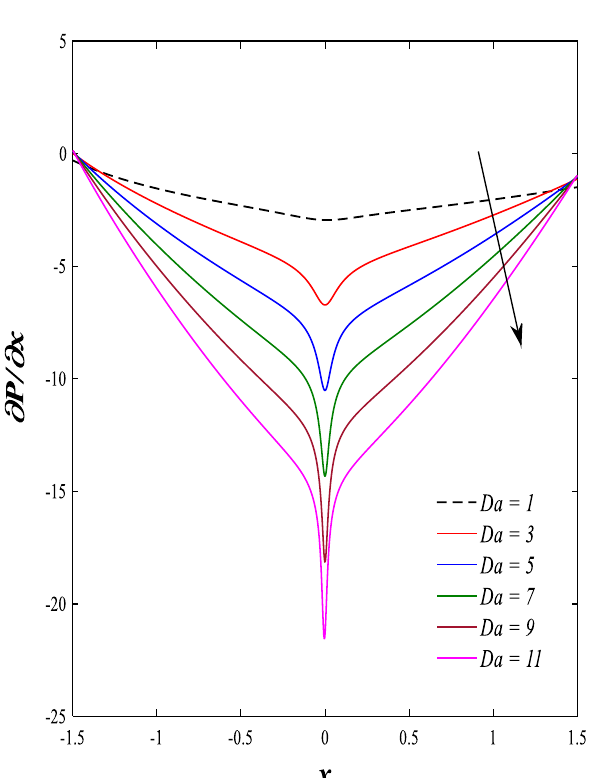
Figure 24. Effect of Darcy number Da on the pressure gradients